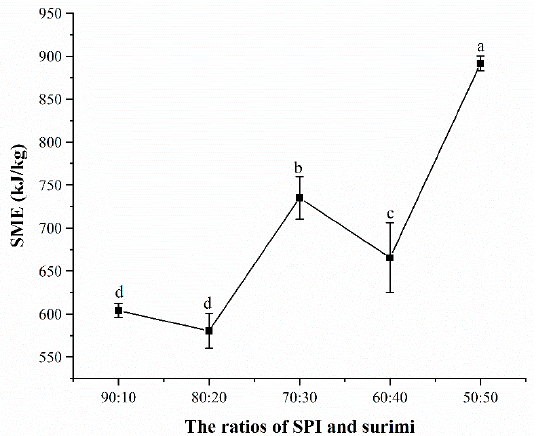
Figure 4. SME during the high-moisture extrusion processing of the SPI and surimi blends. Differ- ent letters mean significant differences ( p <